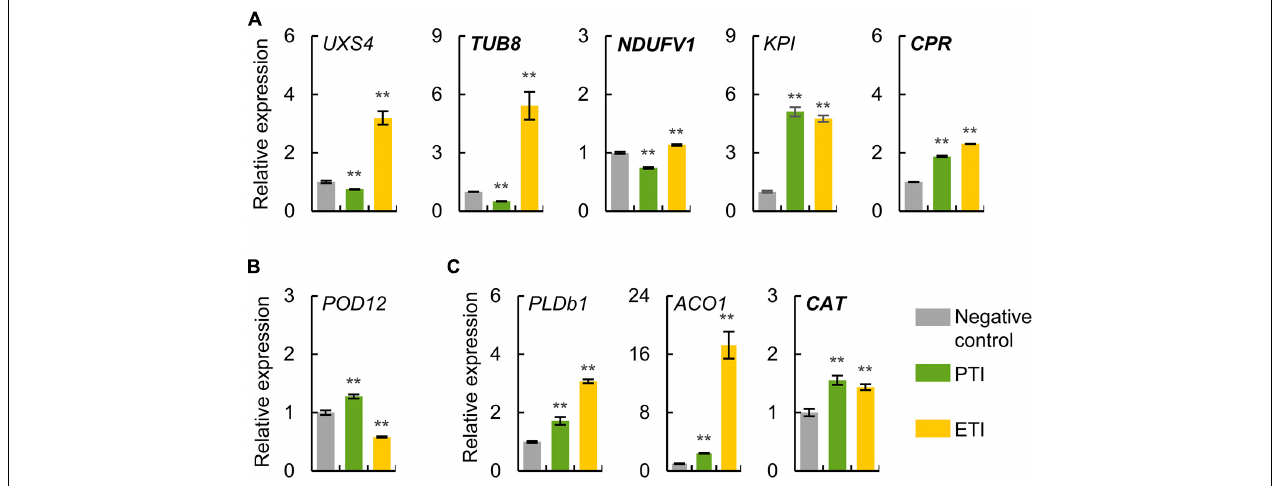
FIGURE 5 | Expression analysis of potential markers for PTI and ETI using qRT-PCR. Relative mRNA expression levels of ETI-specific (A) , PTI-specific (B) , and common induced (C) proteins were determined in four-week-old tomato leaves treated with different Pst mutants to induce ETI or PTI. Normal italic and bold italic names indicate conserved defense-related proteins and newly identified proteins, respectively. The actin gene was used as an internal reference. The values were presented as mean ± SD ( n = 3). Significant differences between negative control and treatment are marked with asterisks (** P < 0.01, Student’s t test). The abbreviations of the genes refer to their homologous proteins in Figure 4D and Supplementary Table 11 . TABLE 2 | Conserved differentially phosphorylated sites in tomato and Arabidopsis in response to PTI and/or ETI activation. Tomato